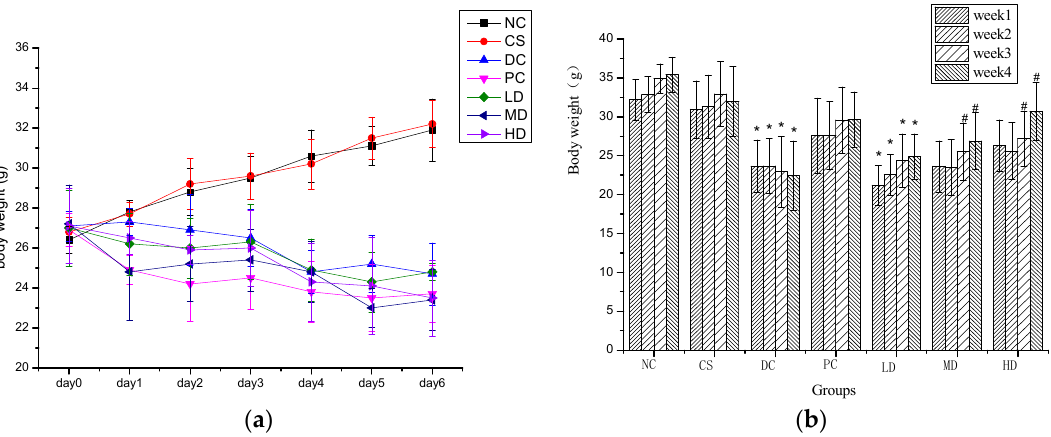
Figure 1. ( a ) Body weight of normal and STZ-induced diabetic mice in first 6 days after the STZ treatment; ( b ) Body weight of normal and STZ-induced diabetic mice in four weeks. Results were presented as means ± SD ( n = 10). The columns of each index in have * p < 0.05, vs. NC; # p < 0.05, vs. week 1. NC, CS, DC, PC, LD, MD and HD are abbreviations for non-diabetic control group, non-diabetic CSFs high dose group, diabetic control group, diabetic CSFs low dose group, diabetic CSFs medium dose group, and diabetic CSFs high dose group, respectively.